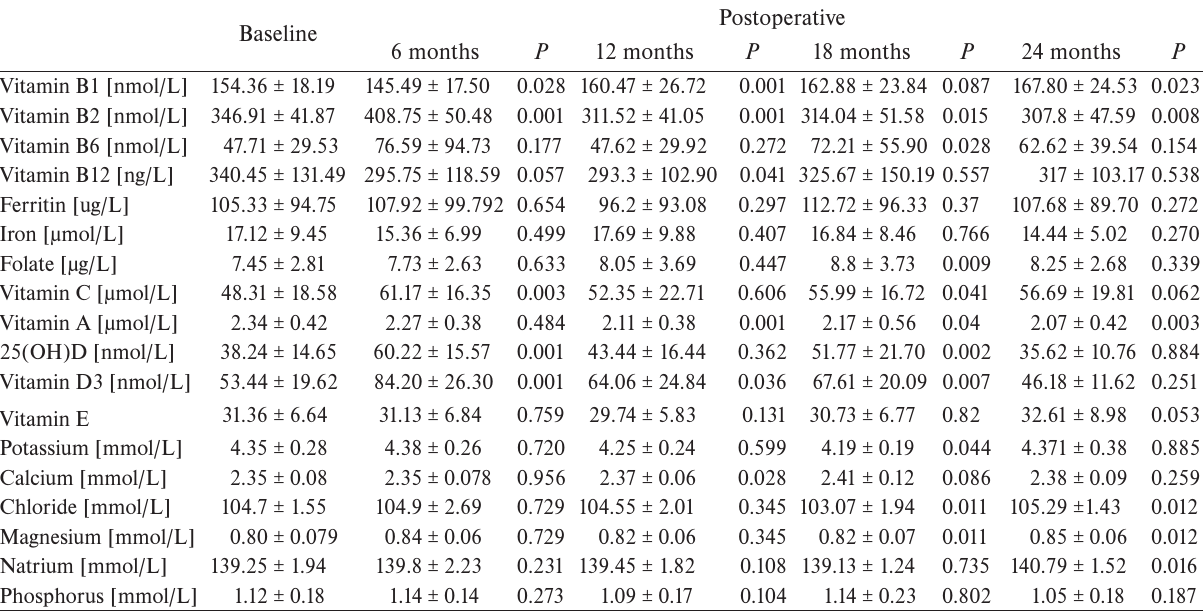
Table 4. Micronutrient parameters before and 6, 12, 18, and 24 months after ESG (n=20).